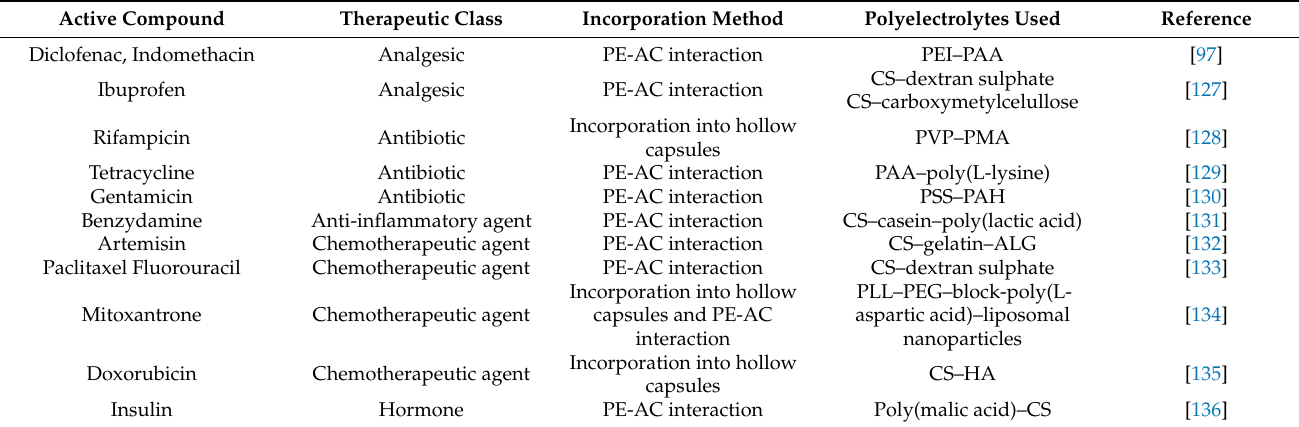
Table 1. Active compounds incorporated in